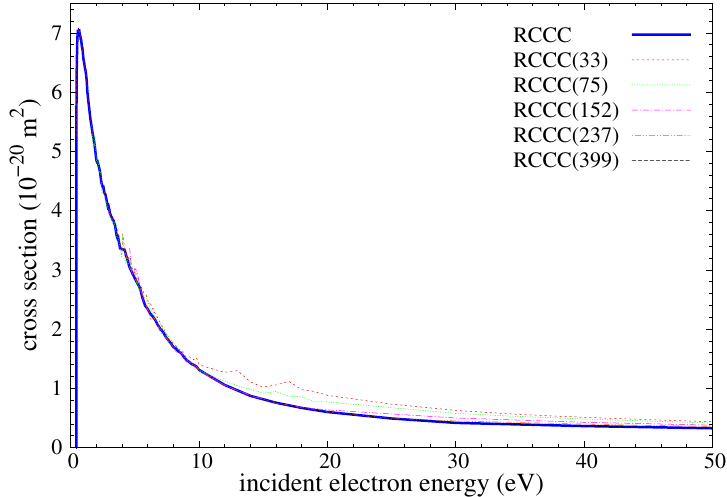
Figure 8. Convergence of the RCCC-integrated cross section with number of states included.